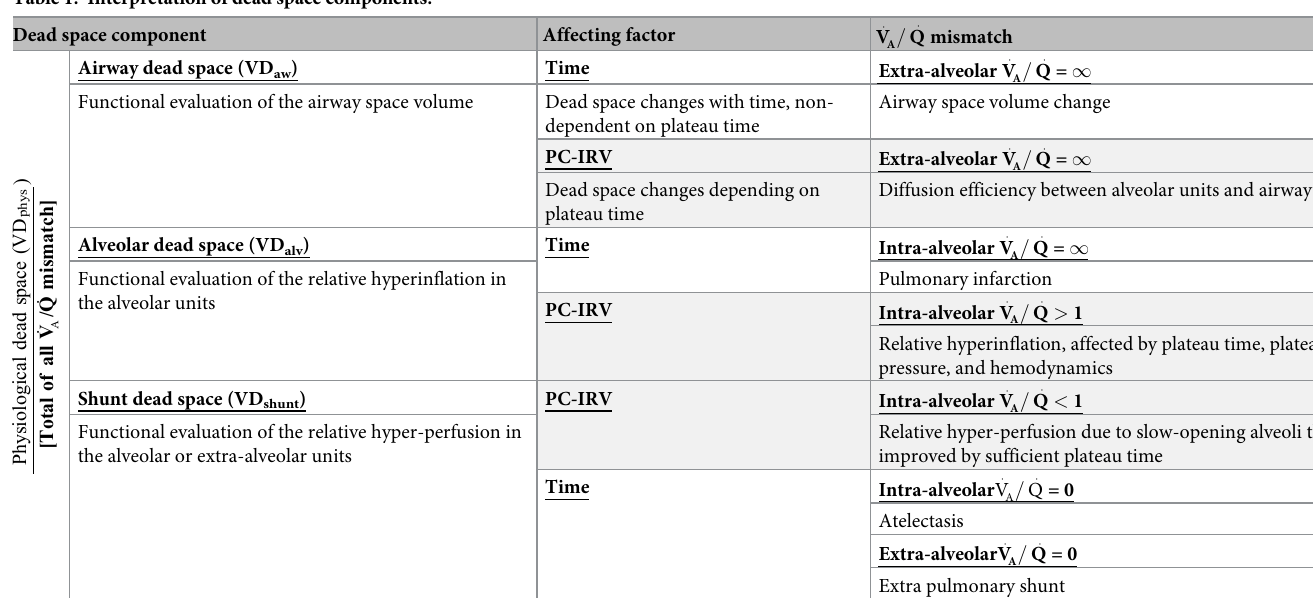
There were no significant differences in the patient and surgical characteristics. No signifi- cant differences were observed in the respiratory or hemodynamic parameters, or the rate of each dead space component between the groups at T with the same initial ventilator set- Baseline tings, including the VCV mode, in both groups (Table 2). During intervention, the I/E ratio was set at 2/1 for 10 patients and at 1.5/1 for 4 patients in the PC-IRV group. and at 1/2 for all 13 patients in the VCV group. Stroke volume variation in the PC-IRV group was higher compared with that in VCV group. The plateau pressure, P CO , and stroke volume variance increased with time, while the expired tidal volume and a 2 static compliance decreased with time.